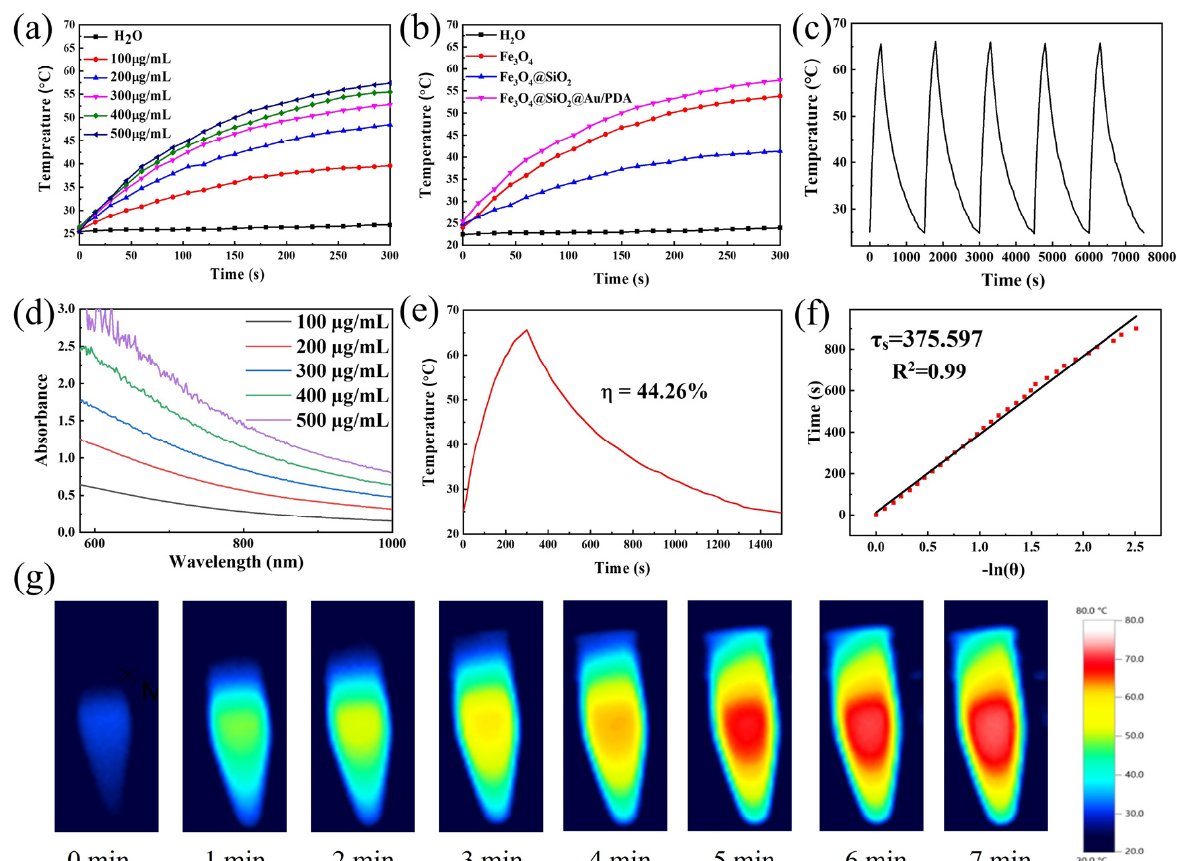
Figure 7. Photothermal performance of Fe 3 O 4 @SiO 2 @Au/PDA nanochains. Heating curve of differ- ent concentrations of Fe 3 O 4 @SiO 2 /Au/PDA under 808 nm laser irradiation ( a ), heating curve of dif-